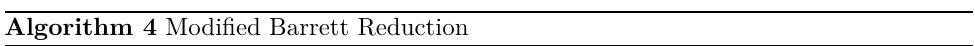
Algorithm 4 Modified Barrett